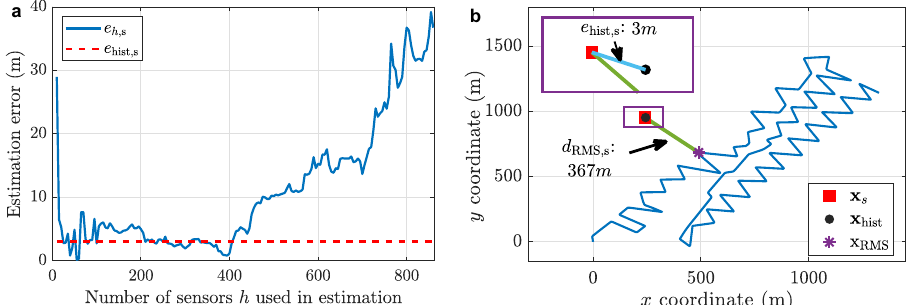
Fig. 8 Error in the blind source position estimation. a Non-blind error estimation based on Eq. (1) as a function of the number of sensors h used in the process. Supplementary Fig. 6 shows location estimation for different channels h , comparing the absolute error with respect to the sensing optical fi bre and actual source position. b Illustration of the estimated x (cid:3) (black circle) and actual x s (red square) source location, compared to the sensing optical fi bre location (using the DAS channel with the highest RMS value x RMS as a reference point). The Inset shows a zoom-in of the relevant area of interest, showing a very small error of 3 m in the estimation compared to the 367 m separating the acoustic source from the sensing fi